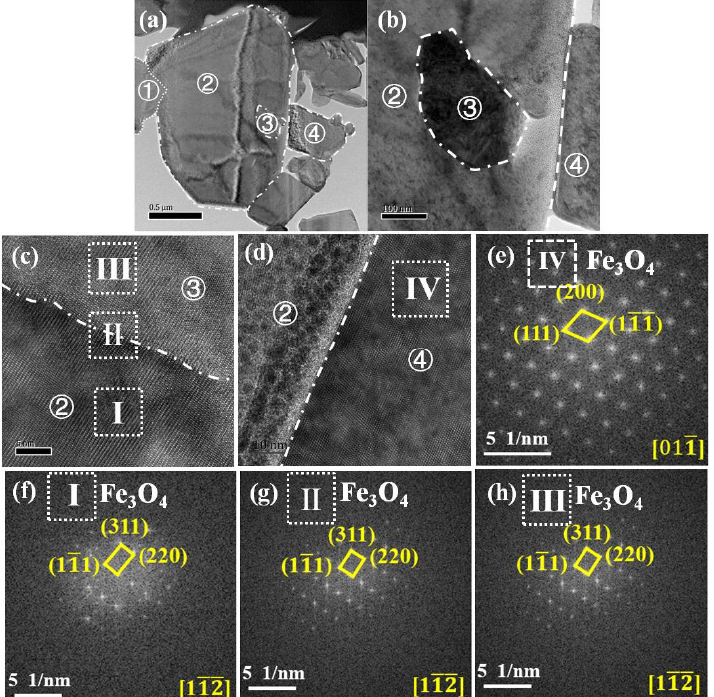
Figure 9. ( a ) TEM image of local magnification of the position of the right rectangle in Figure 8a. ( b ) TEM image of local magnification of the particle ③ in Figure 9a. ( c ) HRTEM image of the interface between particle ② and particle ③ in Figure 9b. ( d ) HRTEM image of the interface between particle ② and particle ④ in Figure 9b. ( e ) The FFT patterns of locations Ⅳ are marked by the rectangle in Figure 9d. ( f – h ) The FFT pattern of locations I, II, and III is marked by the rectangle in Figure 9c.